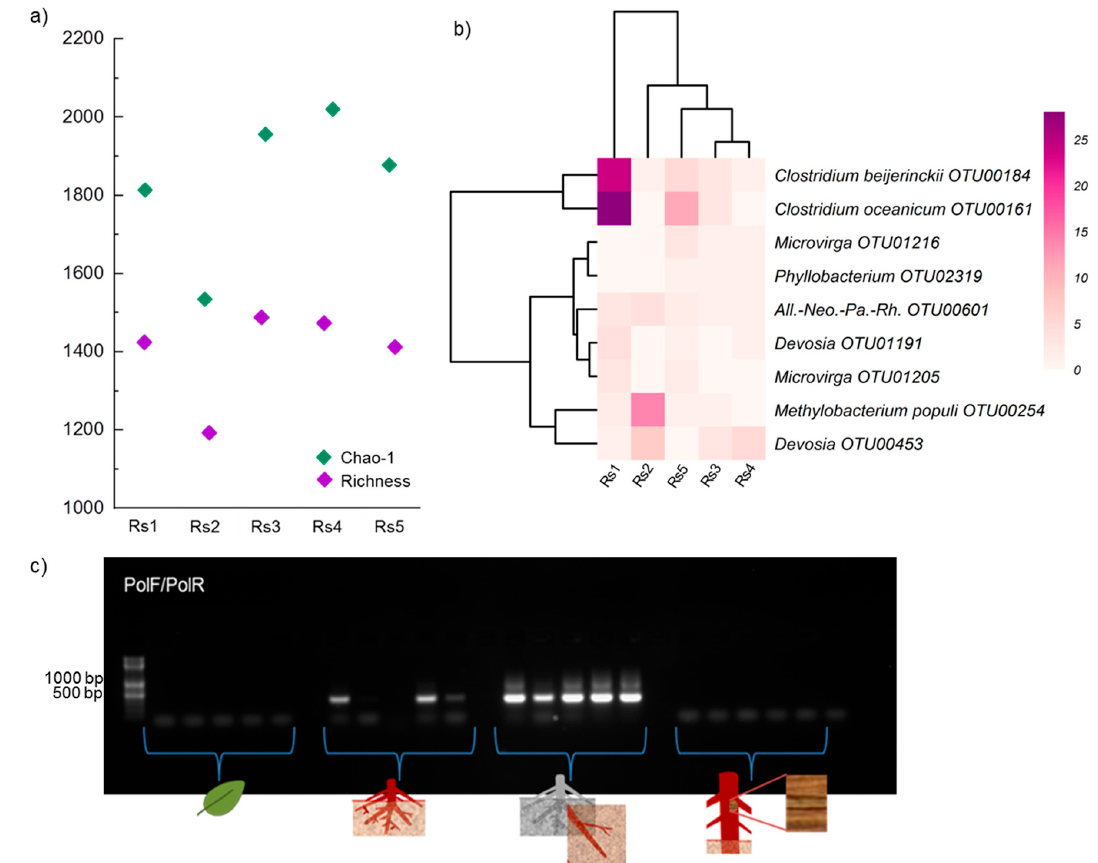
Figure 1. ( a ) Observed and Chao1-estimated richness of the bacterial microbiome in the five samples of rhizosphere soil (Rs1-Rs5), ( b ) heatmap of N-fixing bacteria (based on abundance data) in the samples, and ( c ) PCR results obtained using PolF/PolR primers to detect the nifH gene (360-bp) in the four soil and plant compartments (left to right: leaf, root, rhizosphere soil, and stem).